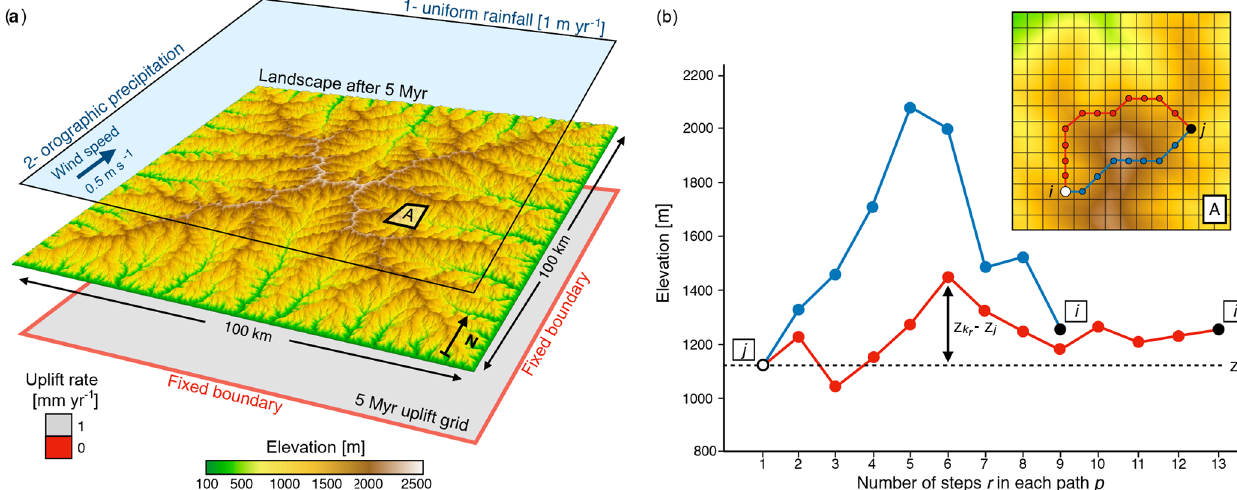
Figure 1. (a) Experimental design showing a modelled landscape after 5Myr and the controlling forcing conditions. Two scenarios are run. In the first one a constant precipitation (1myr − 1 ) is applied; then, in the second, an orographic precipitation model is used with constant wind speed (0.5ms − 1 ) coming from the south. For both scenarios, the model is forced with an initial uplift phase (uniform rate of 1mmyr − 1 ) through the first 5Myr. (b) Approach used to compute the closeness measure ( C ji ) required to quantify landscape elevational connectivity (LEC) based on the topography grid (e.g. region A) defined in panel (a) . Two possible paths connecting site j to i (inset) are proposed with their corresponding elevation profiles. Associated costs are computed following Eq. (6) ( P L r = associated with the red path is smaller than that of the blue one as it travels through sites with elevations more similar to z j (adapted from Bertuzzo et al.,